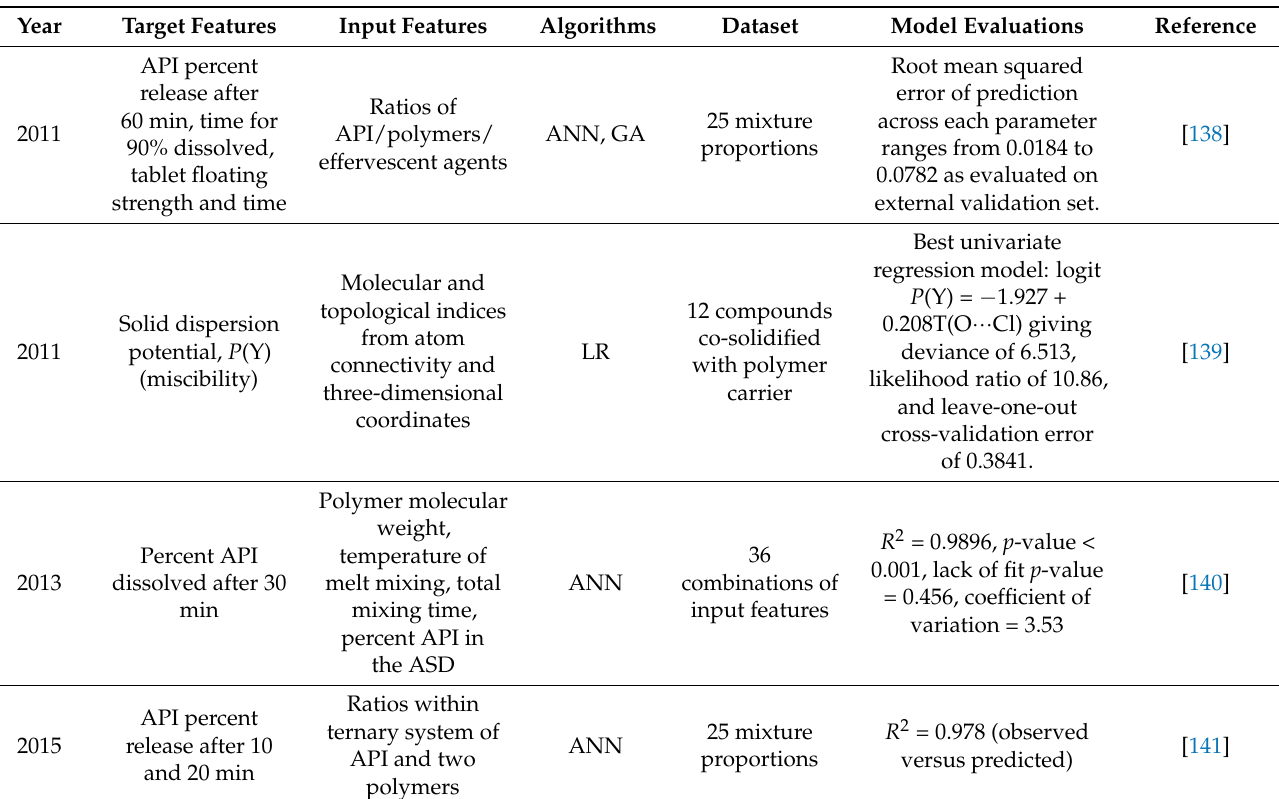
Table 4. Recent ML prediction models for API–carrier ASD properties, stability, and